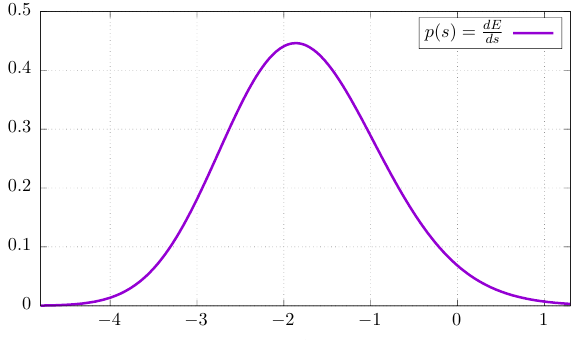
Figure 1: probability density function p ( s ) of the GUE Tracy-Widom